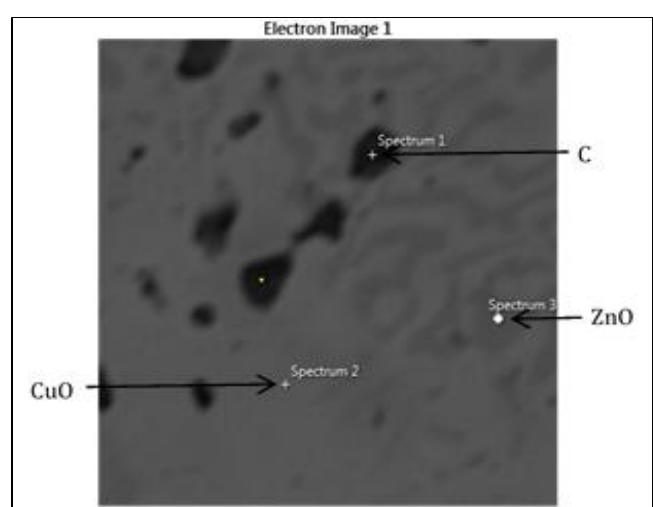
Figure 5: XRD of 0.4% sample. Source: Authors, (2022).